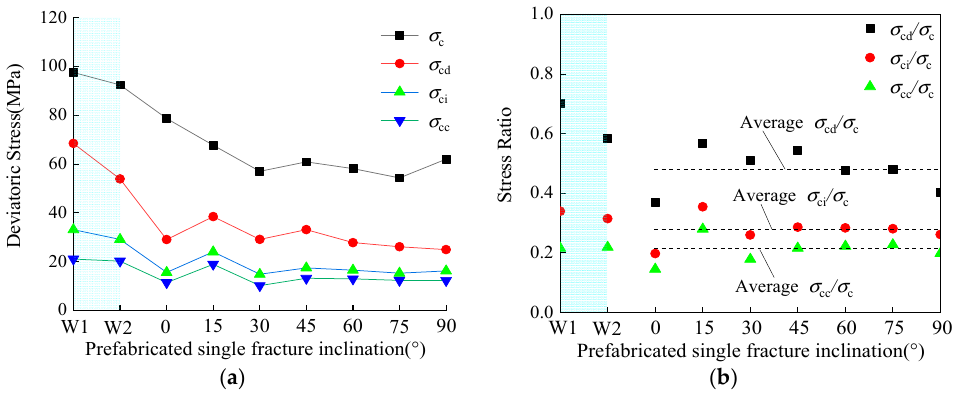
Figure 8. Relationship between fracture inclination and different thresholds, stress ratio of intact and single fracture samples: ( a ) relationship between the different thresholds and fracture inclination and ( b ) relationship between the stress ratio and fracture inclination.